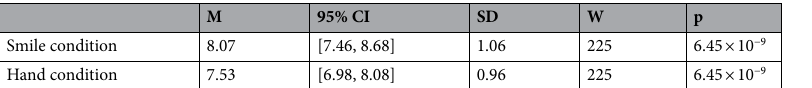
Table 3. Statistics of the Wilcoxon rank-sum test with a chance level under each condition for “sense of agency”.